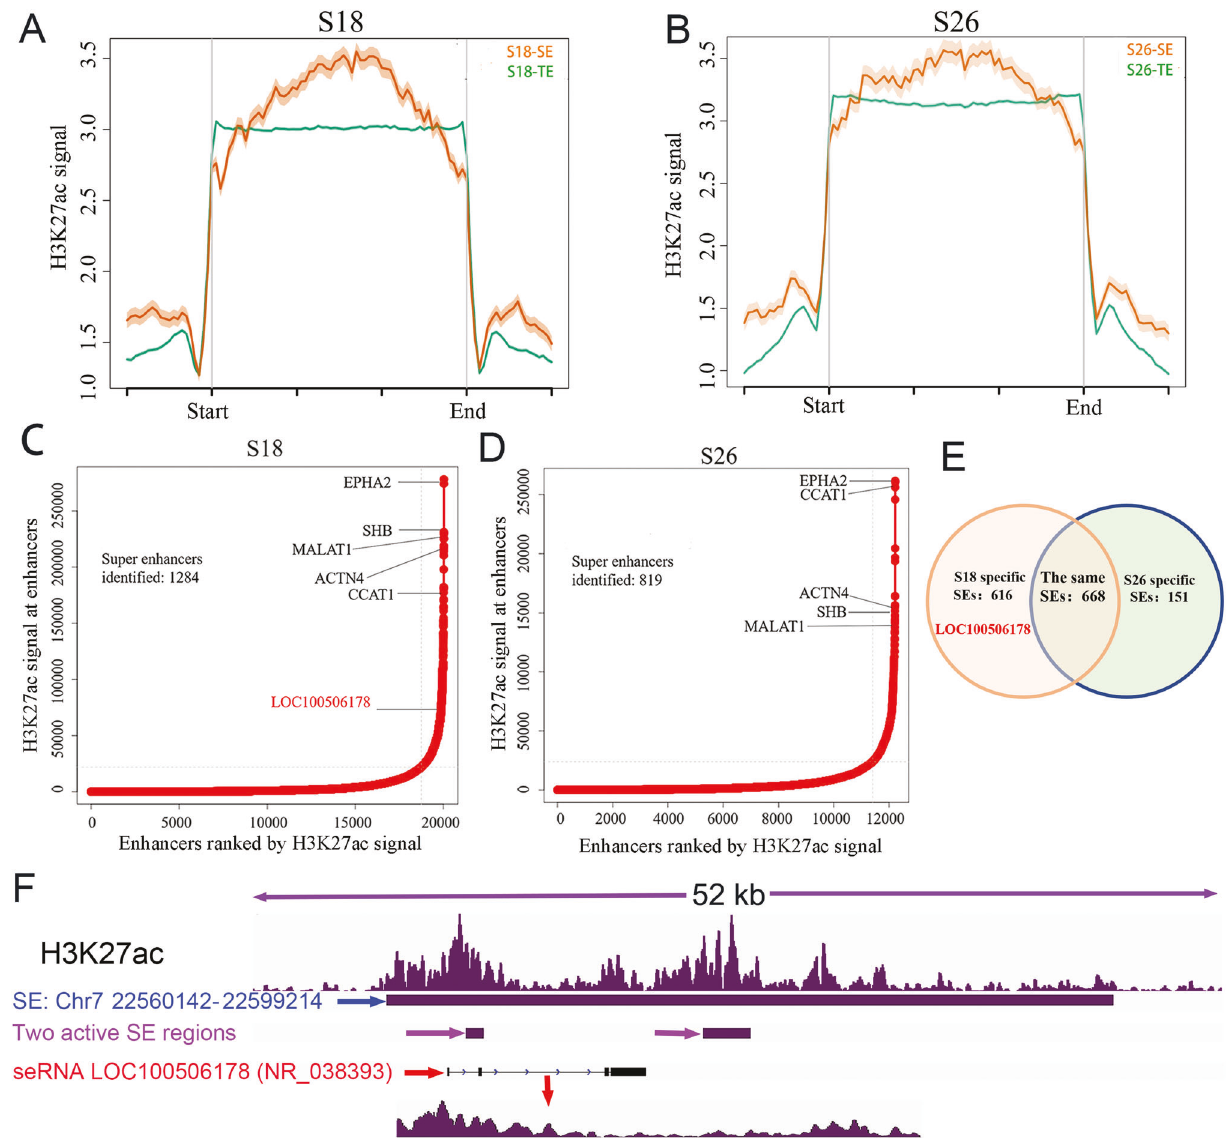
Fig. 1 Comparative analysis of SEs in S18 and S26 cells. A , B H3K27ac signal in SE and TE regions in S18 and S26 cells, respectively; ChIP-seq was performed three replicates. C , D The numbers of identi fi ed SEs and the H3K27ac signal at enhancers in both S18 and S26 cells; the SE regulating LOC100506178 existed only in S18 cells in this study. E The numbers of identical and distinct SEs in S18 and S26 cells were analyzed. F The locations of the S18-speci fi c SE, seRNA LOC100506178, and the active SE regions were visualized by IGV, and the active SE regions transcribed into seRNA LOC100506178 (NR_038393). TE typical enhancer; SE super enhancer. ROSE (Rank Ordering of SE) was utilized to de fi ne SEs and